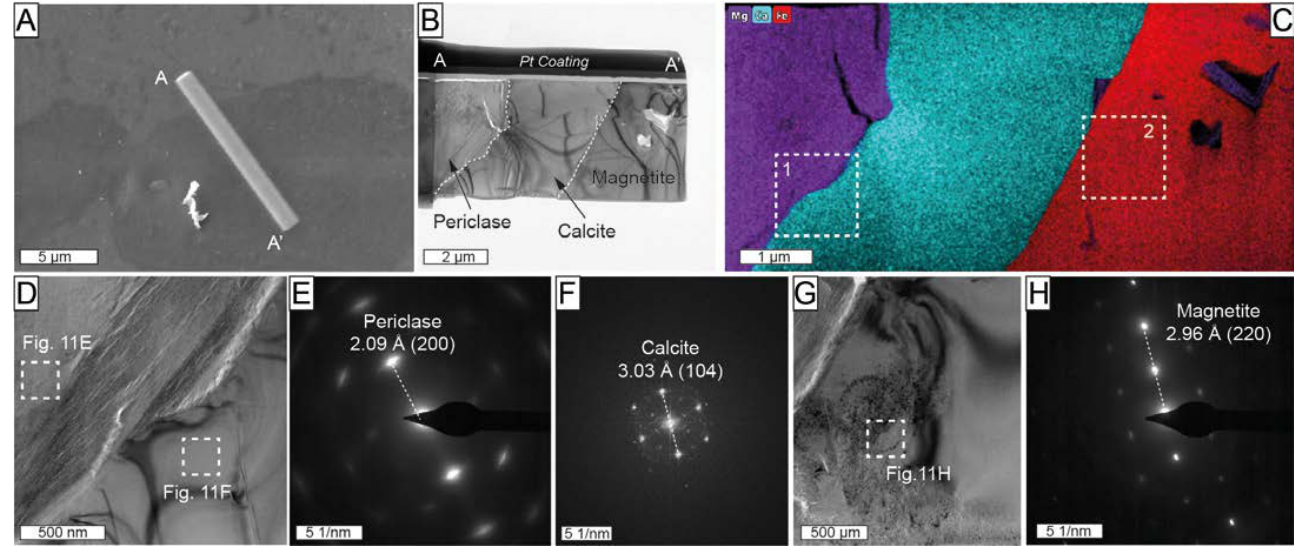
Figure 11. ( A ) Backscattered electron image including the location of thin-foil (A-A’) crosscutting inclusions in Mg-rich magnetite from the magnetite–szaibelyite zone, Sample ROB-24; ( B ) high-angle annular bright-field TEM scanning transmission electron microscopy (HAABF-STEM) image of A-A’ thin foil; ( C ) TEM-EDS elemental maps for Mg (purple), Ca (green blue), and Fe (red); ( D , G ) HAADF images of the area corresponding to rectangles 1 and 2, respectively, marked in ( C ); ( E , F ) SAED of periclase and calcite marked with rectangles in ( D ); ( H ) SAED of magnetite in the area marked with a rectangle in ( G ).